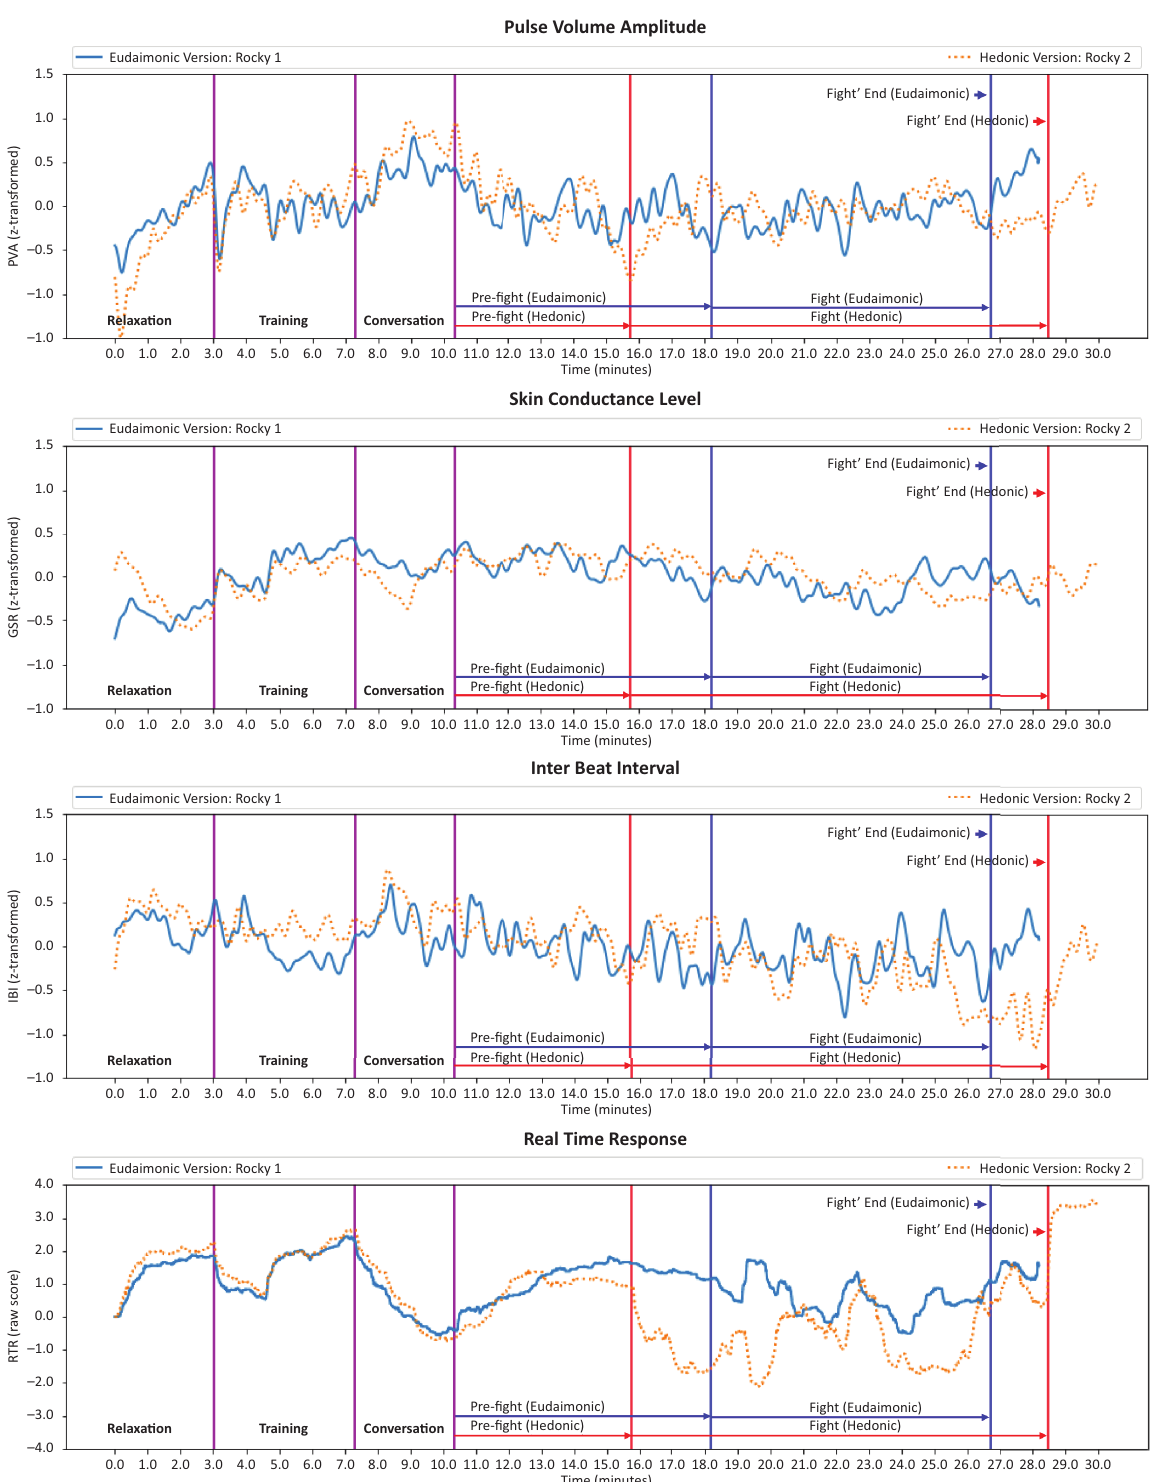
Figure 3. Psychophysiological responses (IBI, PVA, GSR) and audience ratings of pleasure (RTR) during hedonic and eudai- monic stimulus presentation. Note: Lower PVA values indicate arousal